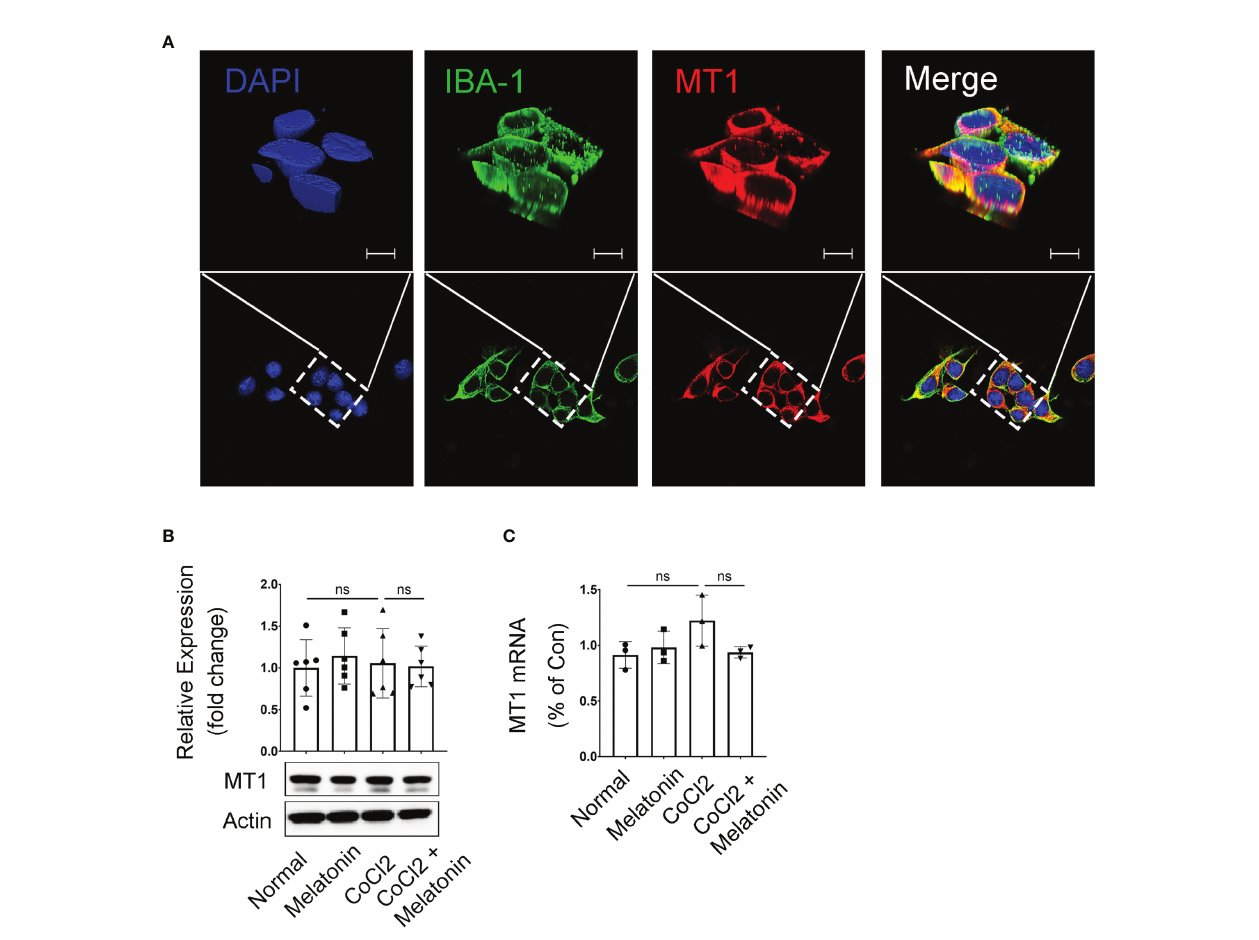
FIGURE 5 | Melatonin receptor expression in CoCl 2 -treated BV2 cells. (A) Representative images of MT1 (red) and IBA-1 (green) immunostaining in microglia. Nuclei were stained with DAPI (blue). (B, C) MT1 proteins (n = 6 per group) and mRNA (n = 3 per group) expression in CoCl 2 -treated BV2 cells with or without melatonin treatment. Data are expressed as mean ± SEM. ns, non-signi fi cant difference. Scale bar, 10 m